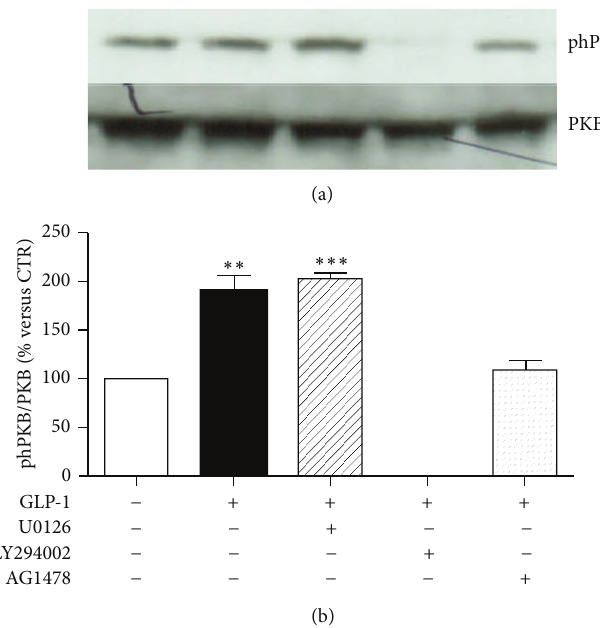
Figure5:PharmacologicalinhibitionofPI3KabrogatesGLP-1-inducedactivationofPKB.ARPE-19cellswereculturedinserum-freemedium for 24 hours and stimulated for 10 minutes with 10nmol/L GLP-1 in the presence or absence of MEK1/2 inhibitor U0126 (10 𝜇 mol/l) or PI3K inhibitor LY294002 (50 𝜇 mol/l), or EGFR inhibitor AG 1478 (0.25 𝜇 mol/l). (a) Representative western blot analysis of PKB phosphorylation (phPKB) and total protein is shown. (b) Quantification of densitometries of western blot bands. Data were expressed as mean ± SE of fold induction relative to total PKB ( 𝑛 = 3 ). ∗∗ 𝑃 < 0.01 ; ∗∗∗ 𝑃 < 0.001 versus cells stimulated with control medium alone.